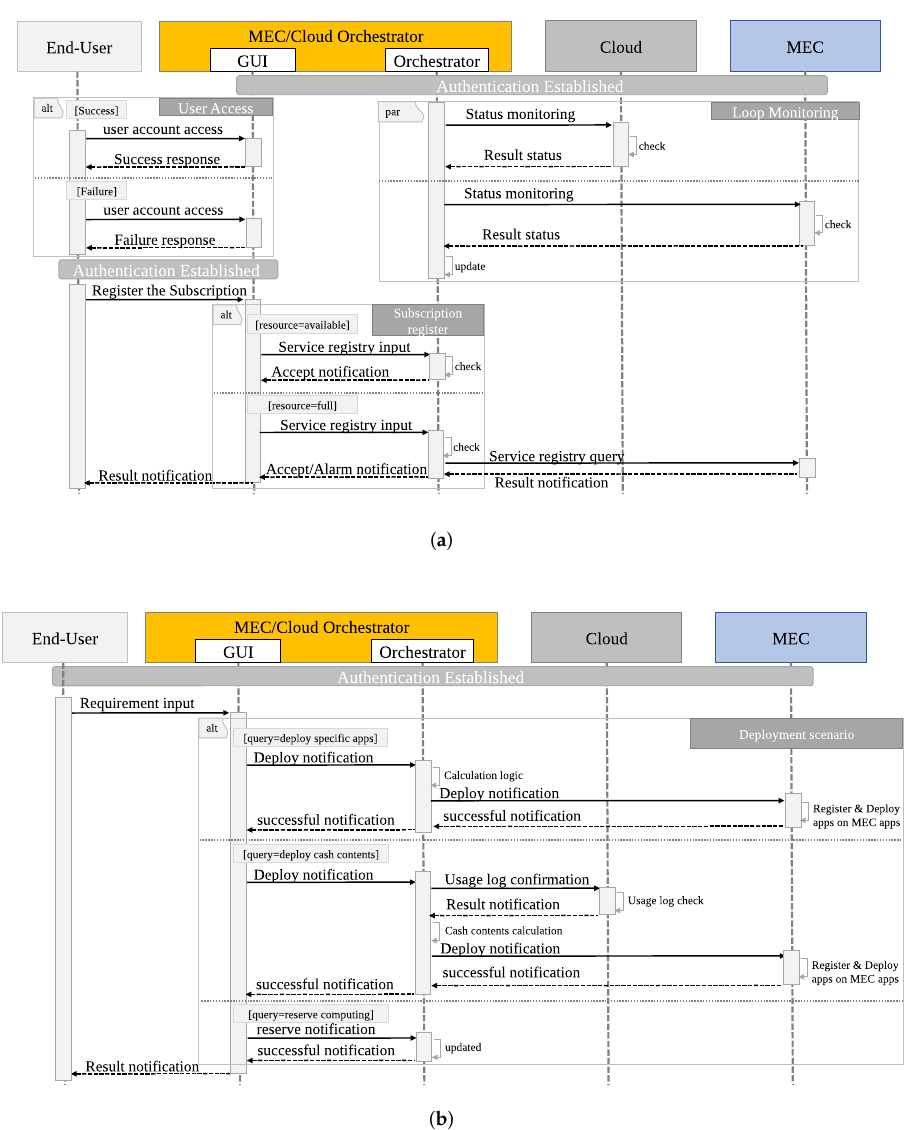
Figure 7. Sequence of MEC/Cloud Orchestrator for implementation: ( a ) subscription registration process and ( b ) deployment